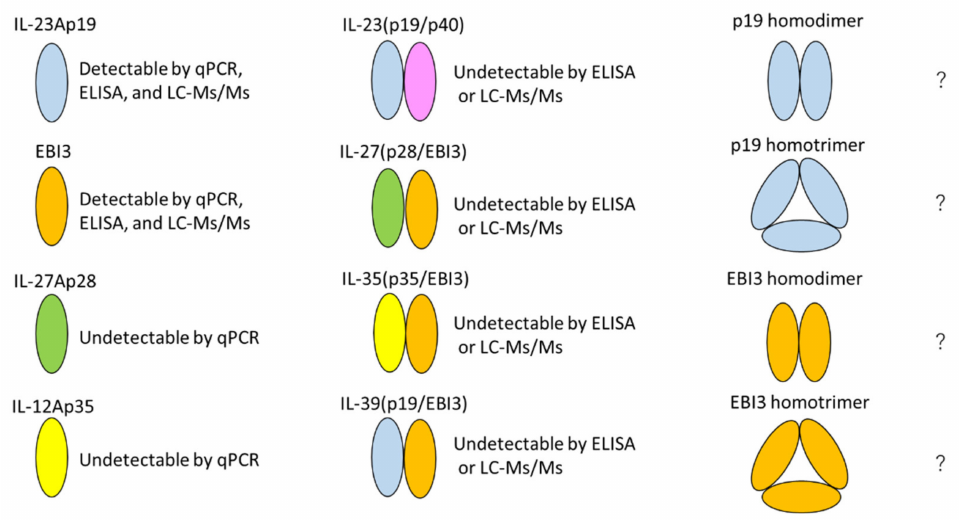
Figure 6. IL-23Ap19- and/or EBI3-including cytokines in epidermal keratinocytes. IL-23Ap19 and EBI3 were detected by qPCR, ELISA, and LC-Ms/Ms. IL-27Ap28 and IL-12Ap35 were undetected by qPCR. IL-23(p19/p40), IL-27(p28/EBI3), IL-35(p35/EBI3), and IL-39(p19/EBI3) were undetected by ELISA or LC-Ms/Ms. This result raises the possibility that IL-23Ap19 and EBI3 produced from epidermal keratinocytes exist as a monomer or homopolymer, such as a homodimer or homotrimer. ?, Not yet detected and